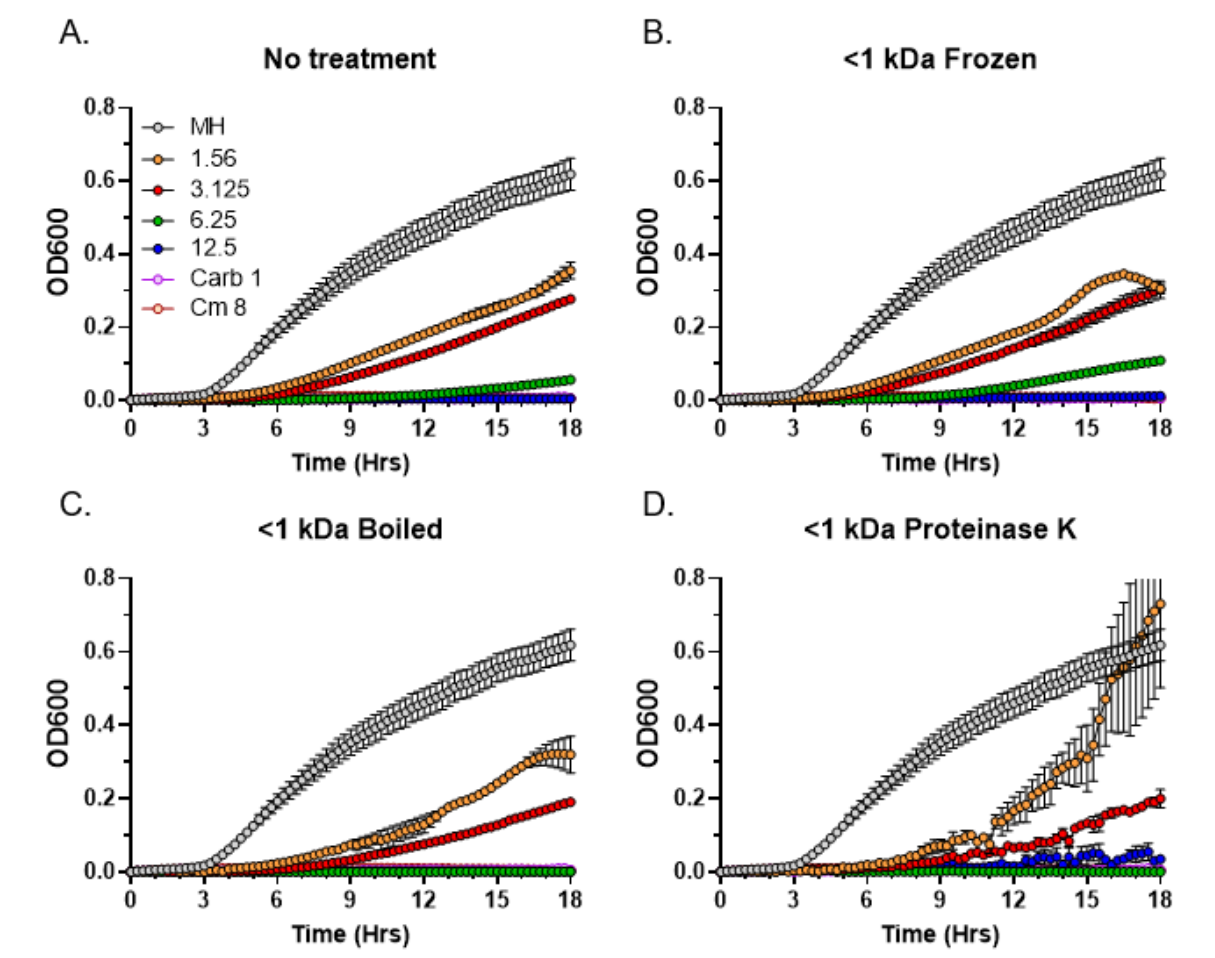
Figure 7. Residual antibacterial activity of C. purpureus R40 <1 kDa fraction after temperature and Proteinase K treatments. Residual activity of exudate from four-week-old C. purpureus R40 culture was tested after treatments by MIC assays against S. aureus. ( A ) Untreated control. ( B – D ) Samples were treated with repeated freezing and thawing ( B ), boiling ( C ) and incubation with Proteinase K ( D ). Samples were tested at exudate concentrations of 1.56, 3.125, 6.25, and 12.5 mg/mL. Carbenicillin (Carb, 1 µg/mL) and chloramphenicol (Cm, 8 µg/mL) were used as positive controls. MH, S. aureus growth in liquid MH medium without addition of exudate fraction.